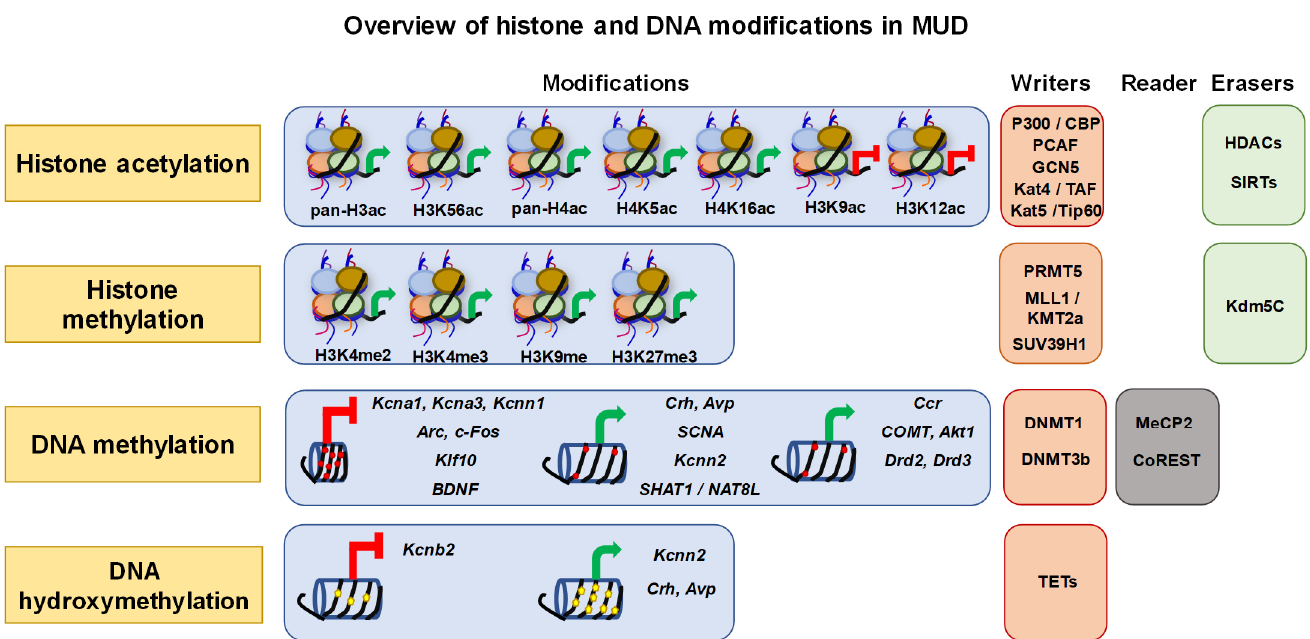
Figure 1. Illustration of aberrant alterations in METH ‐ induced epigenetic modifications and effectors represented by “writers”, “readers”, and “erasers”. Epigenetic writers include histone acetyl ‐ transferases (HATs: p300/CBP; PCAF; GCN5; TAF/Kat4; Tip60/Kat5), histone methyl ‐ transferases (HMTs: PRMT5; MLL1/KMT2a; SUV39H1), DNA methyltransferases (DNMT: DNMT1; DNMT3b), ten ‐ eleven translocase (TET: TET1, 2 and 3), readers include, corepressor for the RE1 ‐ silencing transcription factor (CoREST), methyl ‐ binding protein (MBP: MeCP2) and erasers include, histone demethylase (HDM: Kdm5c), histone deacetylases (HDACs). The green arrow represents transcriptional activation and red block ‐ head arrow represents transcriptional repression. The red circle on DNA strand (DNA methylation) indicate methyl ‐ cytosine; yellow pentagon on the DNA strand (DNA hydroxymethylation) indicates hydroxymethyl ‐ cytosine. ac: acetylation; me: methylation.